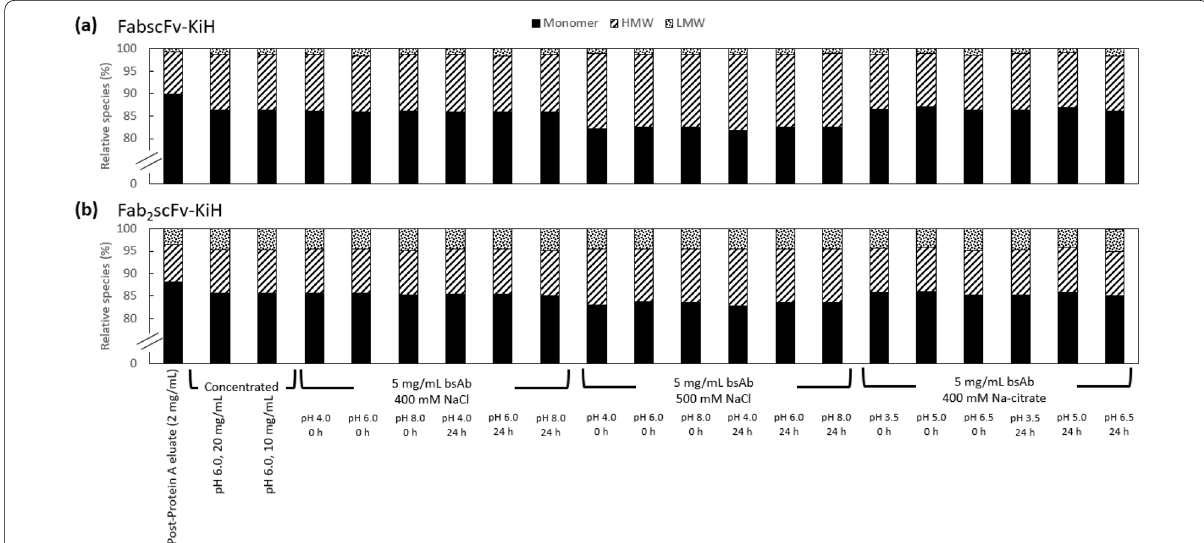
Fig. 2 Stability study of FabscFv-KiH ( a ) and Fab 2 scFv-KiH ( b ) at the various bsAb, pH and salt